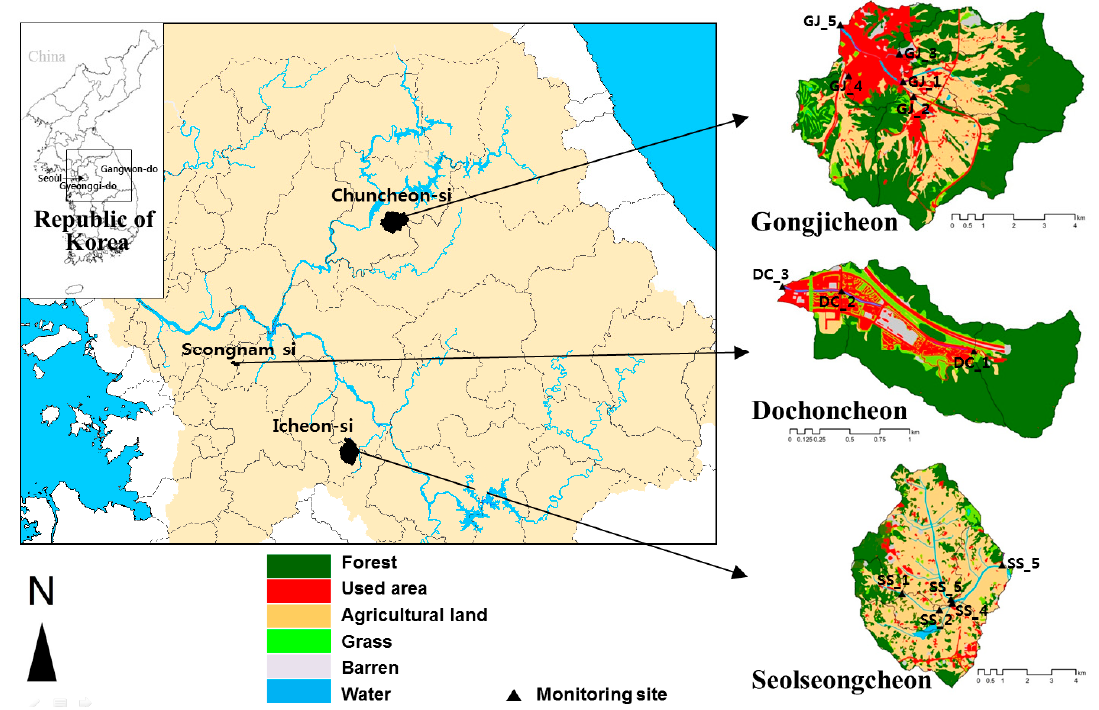
Figure 1. Watersheds monitored in this study and their land cover.